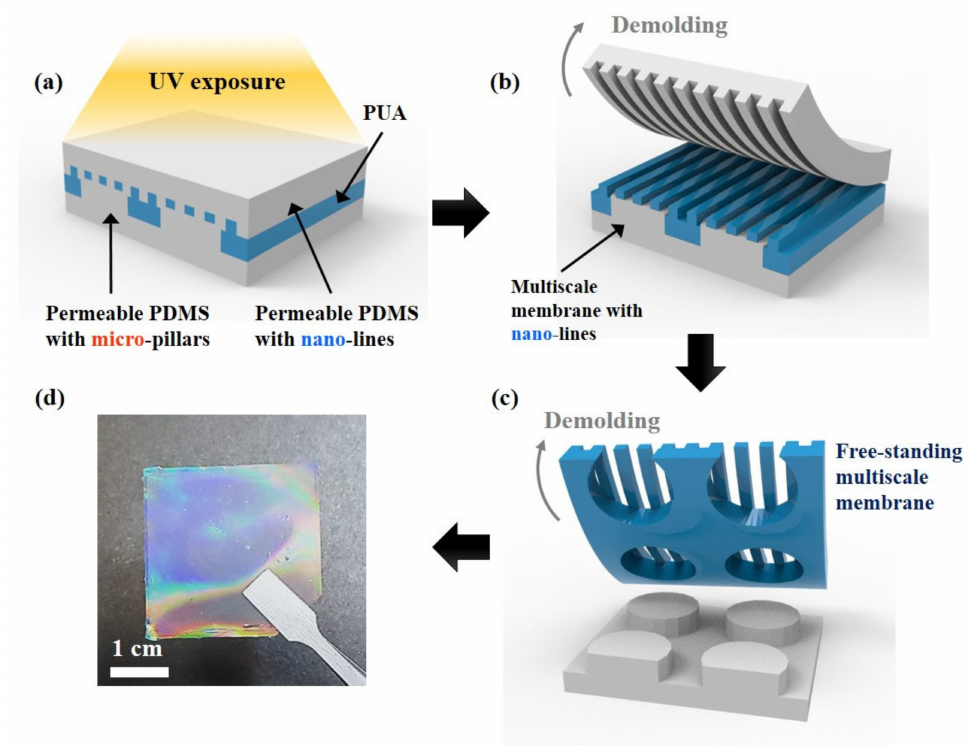
Figure 2. Fabrication process of the free-standing dot-line multiscale polymeric membranes. ( a ) Schematic illustration of the assembled PDMS micro-pillars mold, PUA polymers and PDMS nano-lines mold. ( b ) Peeling o ff the PDMS nano-lines mold. ( c ) Peeling o ff the nano-line and micro-apertures multiscale membrane that is made of PUA; the thin nano-line membrane, which was supported and combined with the micro-apertures membrane. ( d ) Digital camera image of the free-standing and flexible multiscale polymeric membrane with a large